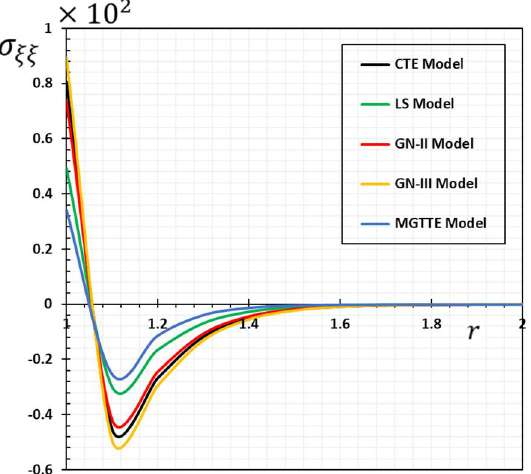
Figure 12. The hoop stress, σ ξξ , versus different thermoelastic models. Figure 12. The hoop stress, (cid:2026) (cid:3093)(cid:3093) , versus different thermoelastic models. Figure 12. The hoop stress, (cid:2026) (cid:3093)(cid:3093) , versus different thermoelastic models. Figure 12. The hoop stress, (cid:2026) (cid:3093)(cid:3093) , versus different thermoelastic models.